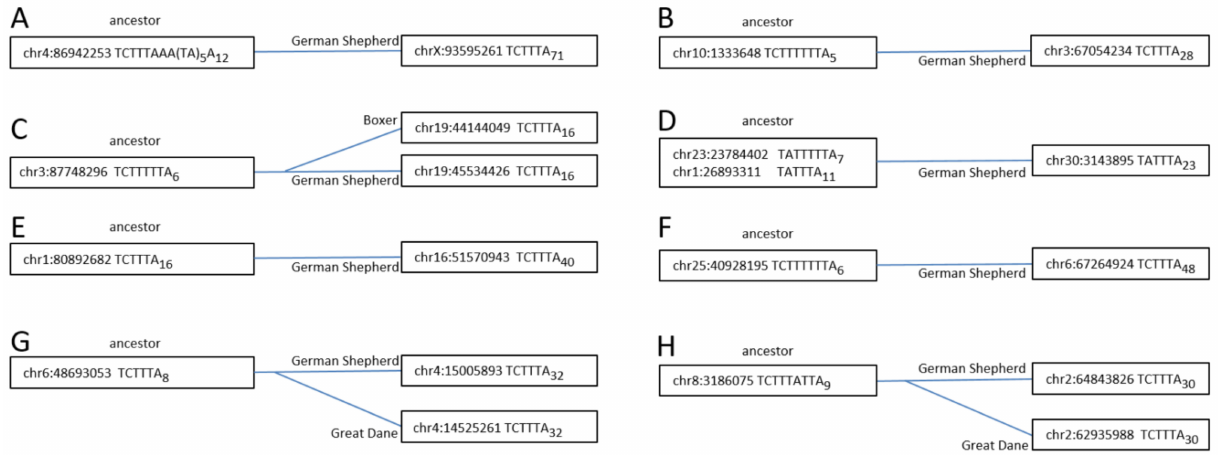
Figure 6. Eight Can_b1Y copies ( A – H ) illustrating their retrotransposition via T + mechanism. The left coordinate, terminator structure, and poly(A) tail length are specified. The left (“ancestor”) boxes include copies present in the genomes of the German Shepherd, Great Dane, and Boxer; the right boxes include daughter copies present in one or two dog breeds. Notice that the daughter copies have much longer poly(A) tails; in three cases (B, C, and F), the terminators are significantly shortened in daughter copies relative to parental